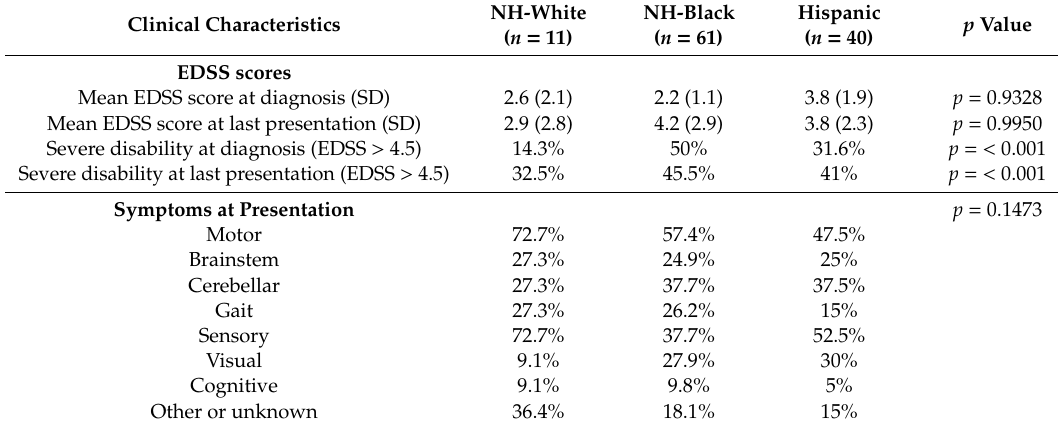
Table 2. Clinical characteristics of MS patients by race /